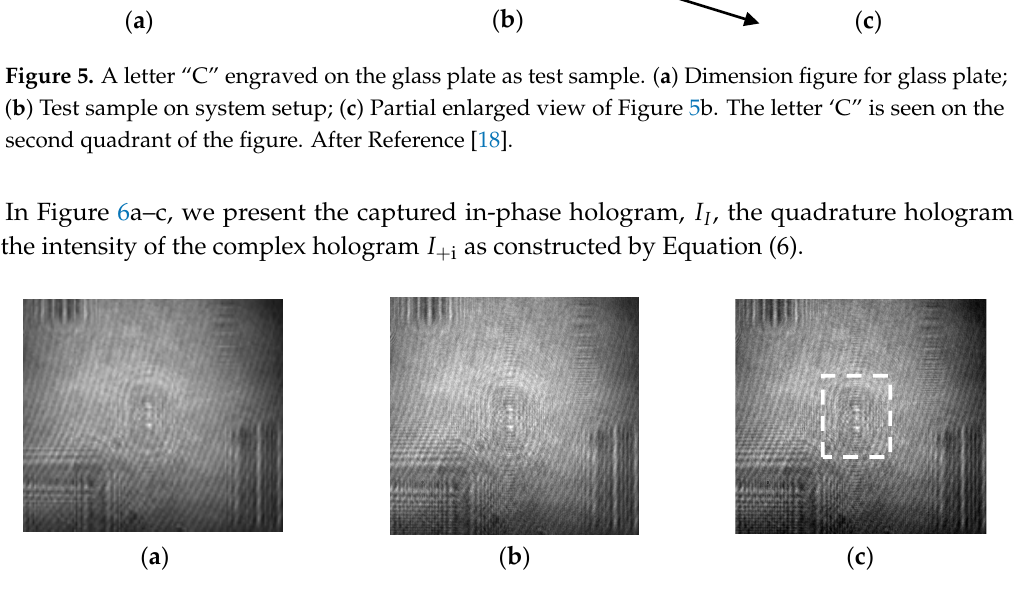
Figure 6. Two phase-shifting holograms and constructed hologram in recording plane. ( a ) In-phase hologram I I ; ( b ) Quadrature hologram I Q ; ( c ) Magnitude of Complex hologram I + i . After Reference [18].